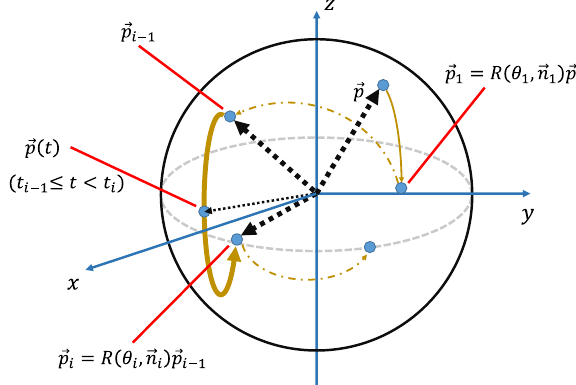
R (θ p by R (θ k , n k ) n 1 ) on the Bloch sphere. The thick curve 1 , (cid:31) � · · · � p i 1 to (cid:31) p i . The i -th part of the summation in Eq. (24) is the � −